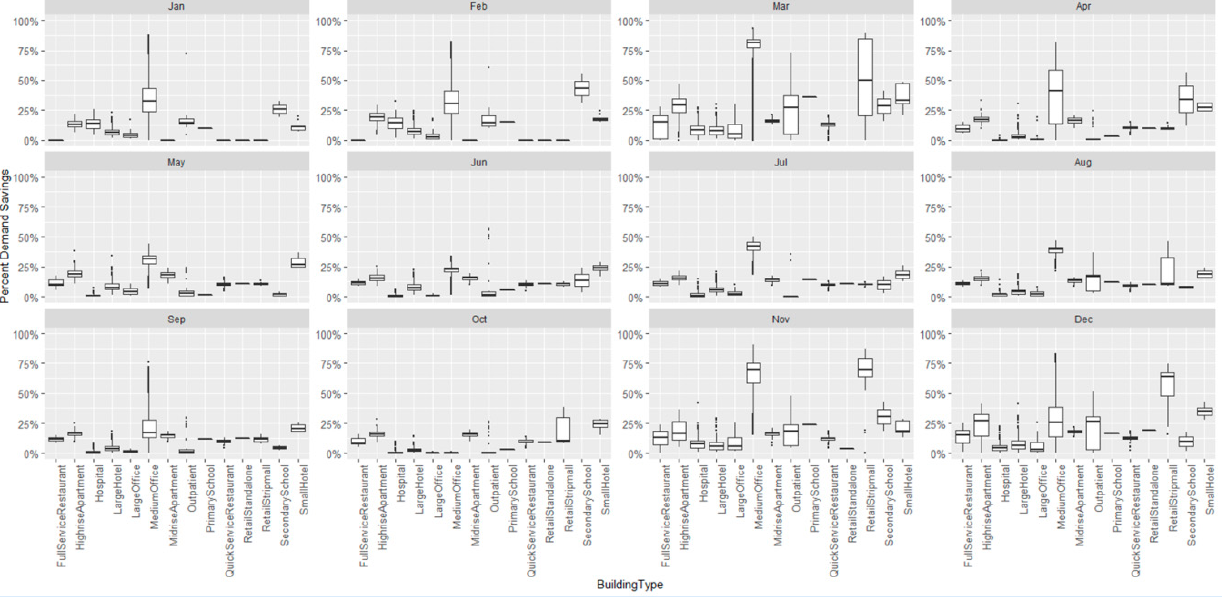
Figure 6. Potential monthly demand reduction achievable with 2.2 °C pre-conditioning by building type.